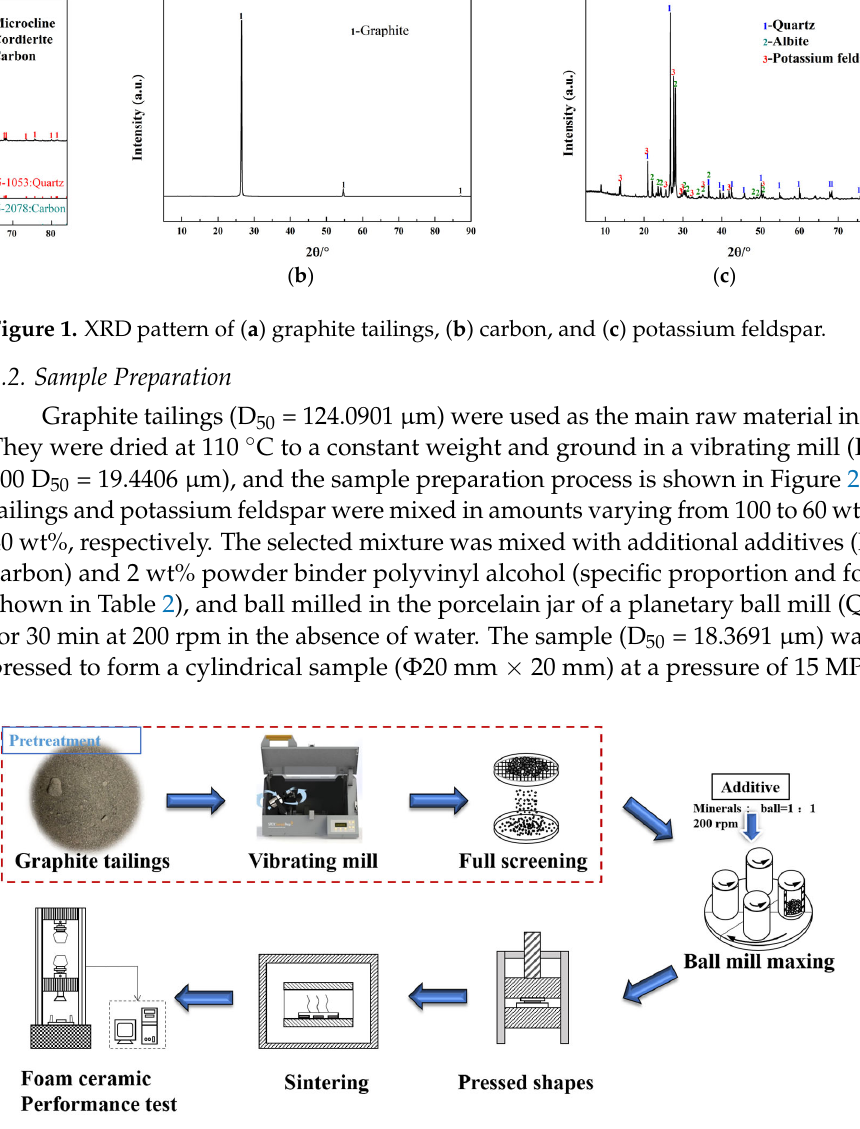
Figure 2. Preparation process of foamed ceramic. Table 2. Composition of sample ingredients (wt%) (2% polyvinyl alcohol was added as powder